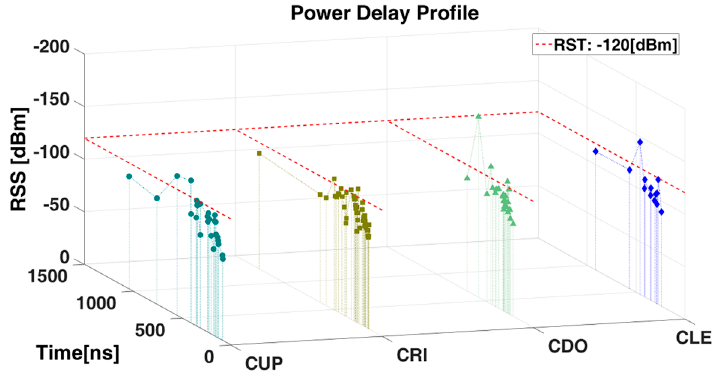
Figure 4. Power Delay Profile.